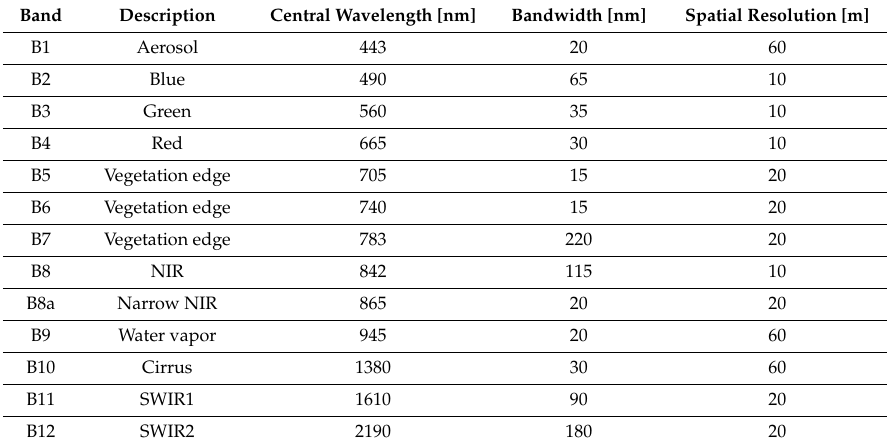
Table 1. Spectral band characteristics of the Sentinel-2 mission (adapted from [51]).